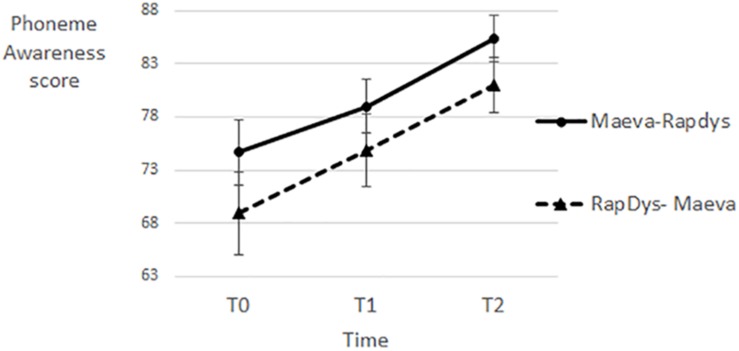
Phonemic awareness scores for each time period and each presentation order.